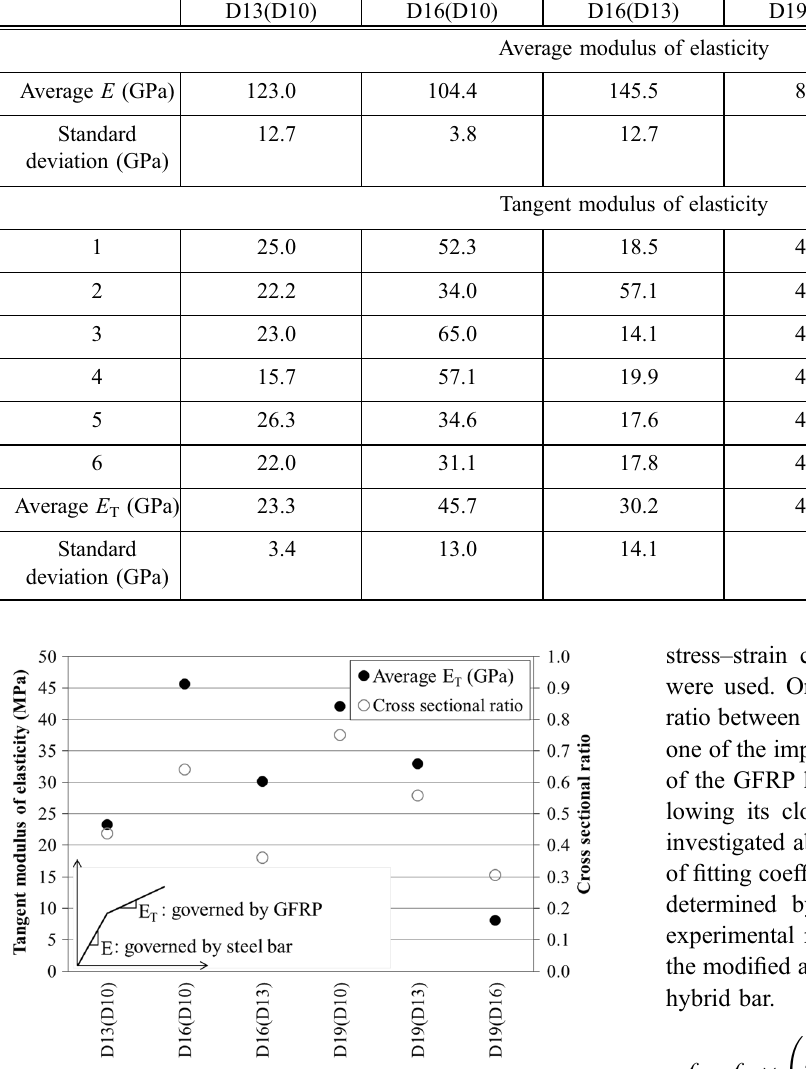
Fig. 10 Relationship between tangent modulus of elasticity and cross sectional ratio.